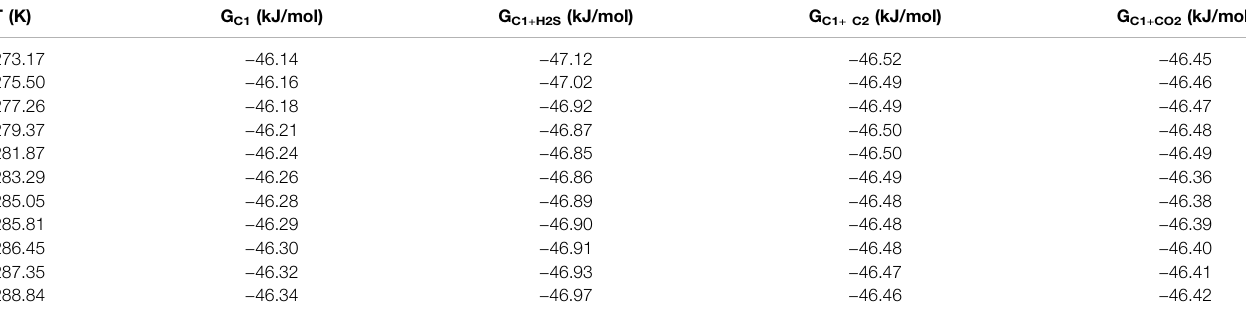
TABLE 4 | Calculated results of free energy of hydrate in 90 mol% CH 4 +10 mol% C 2 H 6 /CO 2 /H 2 S system. G in the table represents Gibbs free energy. T